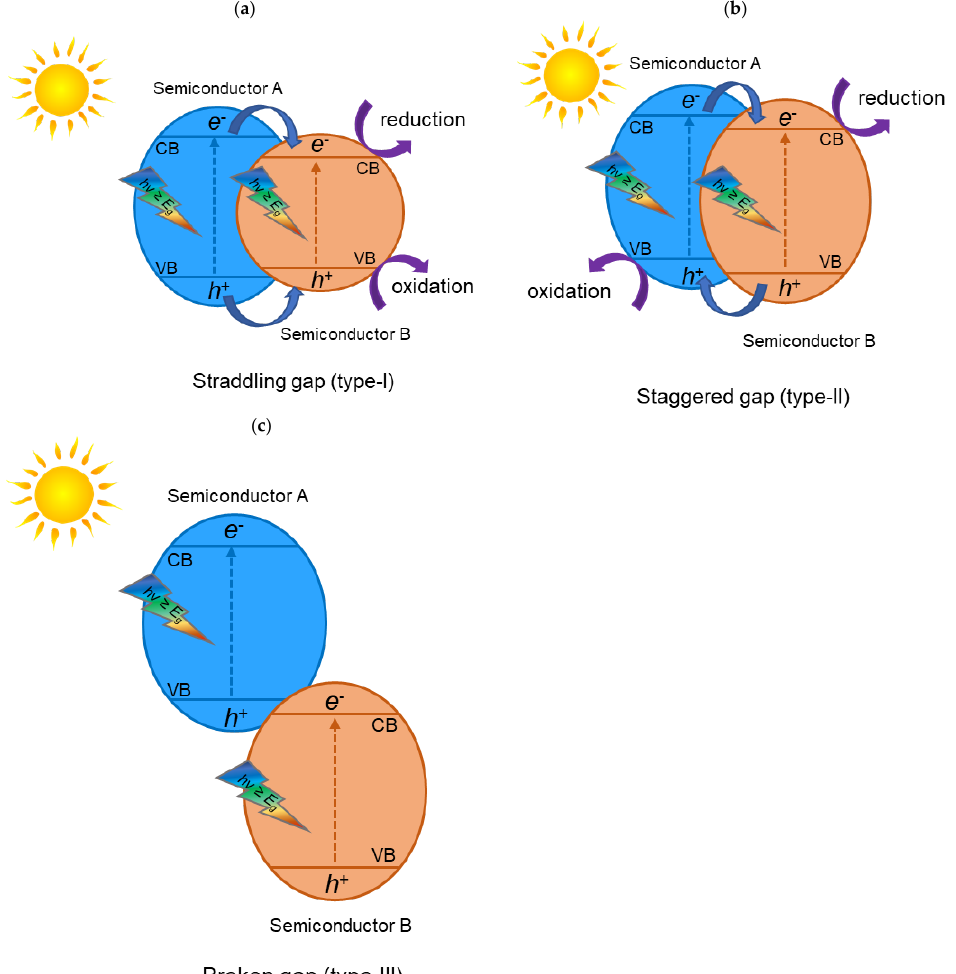
Figure 2. Schematic illustration of the three different types of separation of electron – hole pairs in the case of conventional light-responsive heterojunction photocatalysts: ( a ) type-I, ( b ) type-II, and ( c ) type-III heterojunctions. Adapted according to Refs. [18,19]. ( c ) type-III heterojunctions. Adapted according to Refs.